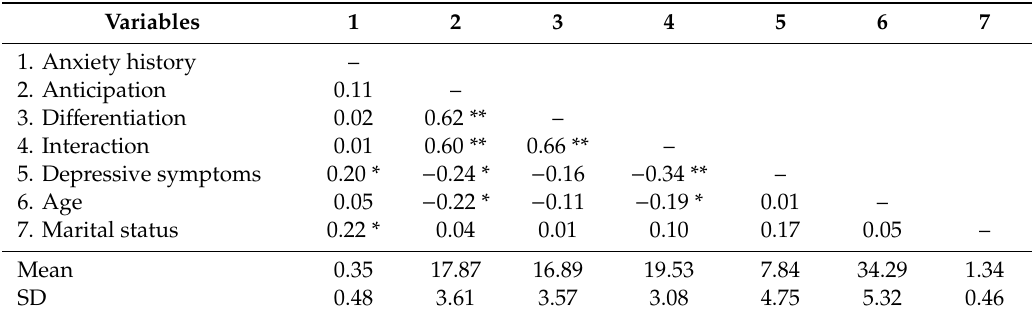
Table 2. Correlation matrix, means, and standard deviations (SD) among Anxiety history, Prenatal Attachment subscales and Depressive symptoms, Age, and Marital status.